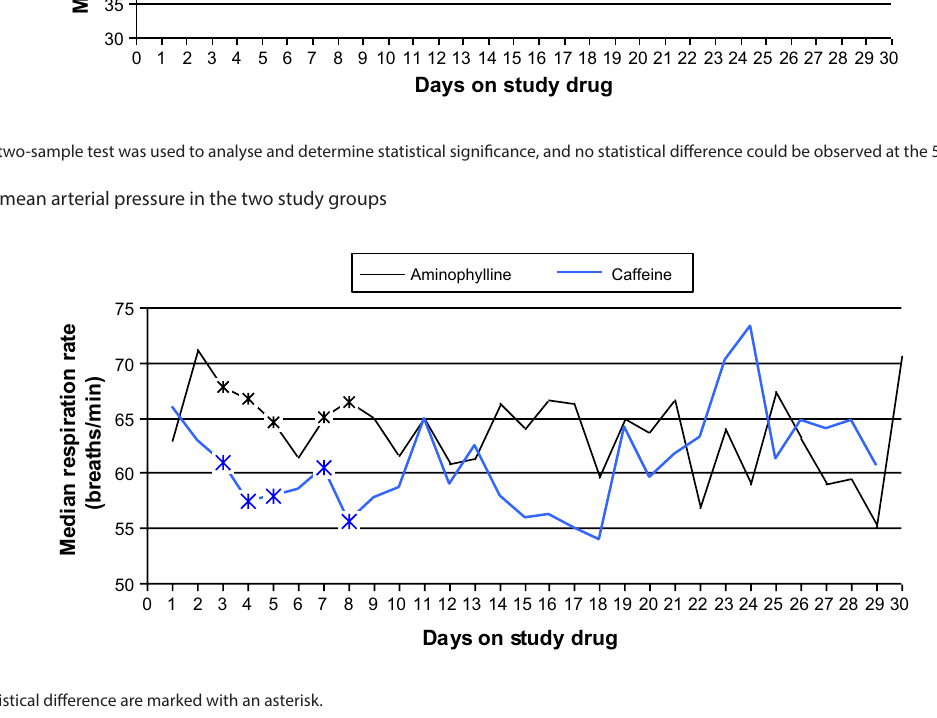
Figure 6: Median respiratory rate in the two study groups